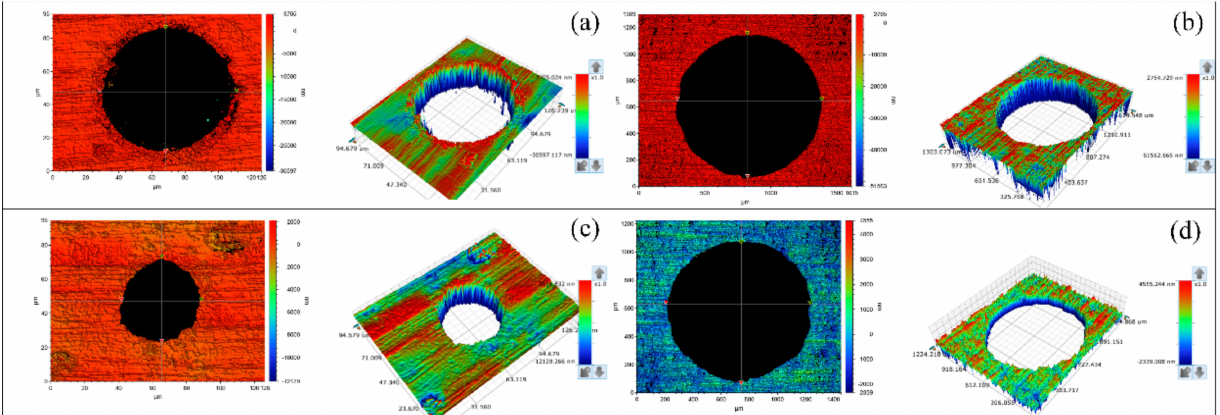
Figure 10. Surface morphology of 304 stainless steel after water jet-guided laser drilling in different paths at the same laser power: ( a ) fixed position drilling upper surface, ( b ) helical drilling upper surface, ( c ) fixed position drilling lower surface, ( d ) helical drilling lower